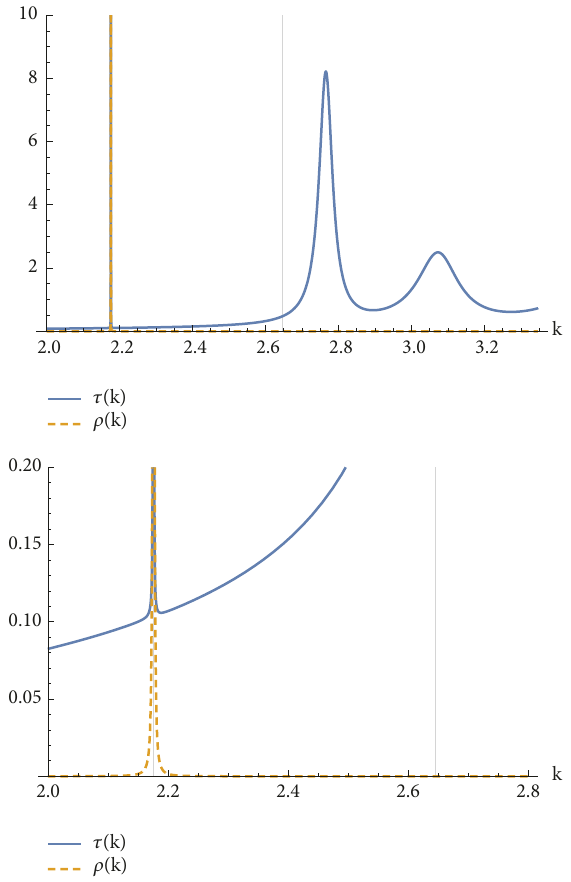
Figure 4: Top : the stationary transmission clock time 𝑡 𝑇 𝑐 (𝑘) (blue) and the wave number distribution 𝜌(𝑘) = |𝑆(𝑘)| 2 (orange, dashed, and arbitrary scale), for 𝑉 0 = 7 , 𝑎 = 1 , 𝑏 = 5 , and 𝑘 0 ≈ 2.175932 ), with the initial state given by (18). Bottom: close view of the above plot for small times. The vertical grey lines in the plots correspond to 𝑘 = 𝑘 0 and 𝑘 = √𝑉 0 . The region of relatively slow growth of the derivative 𝑡 𝑇󸀠 (𝑘) correspond to times around 0.105 𝑎.𝑢. Rydberg atomic units were used in all the plots.